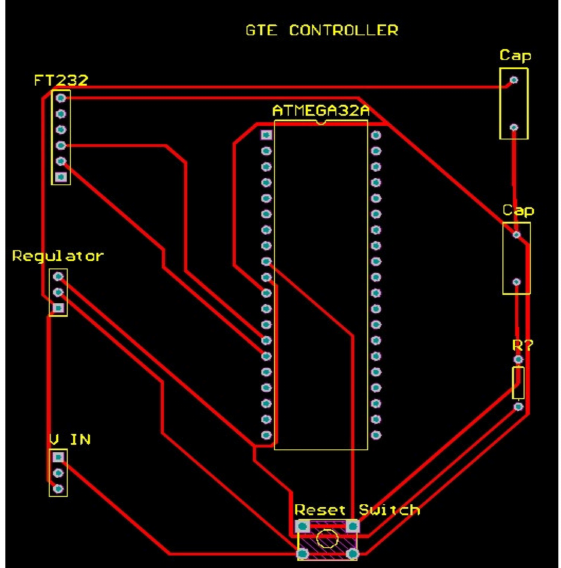
Figure 11. Designed board printed circuit board (PCB).